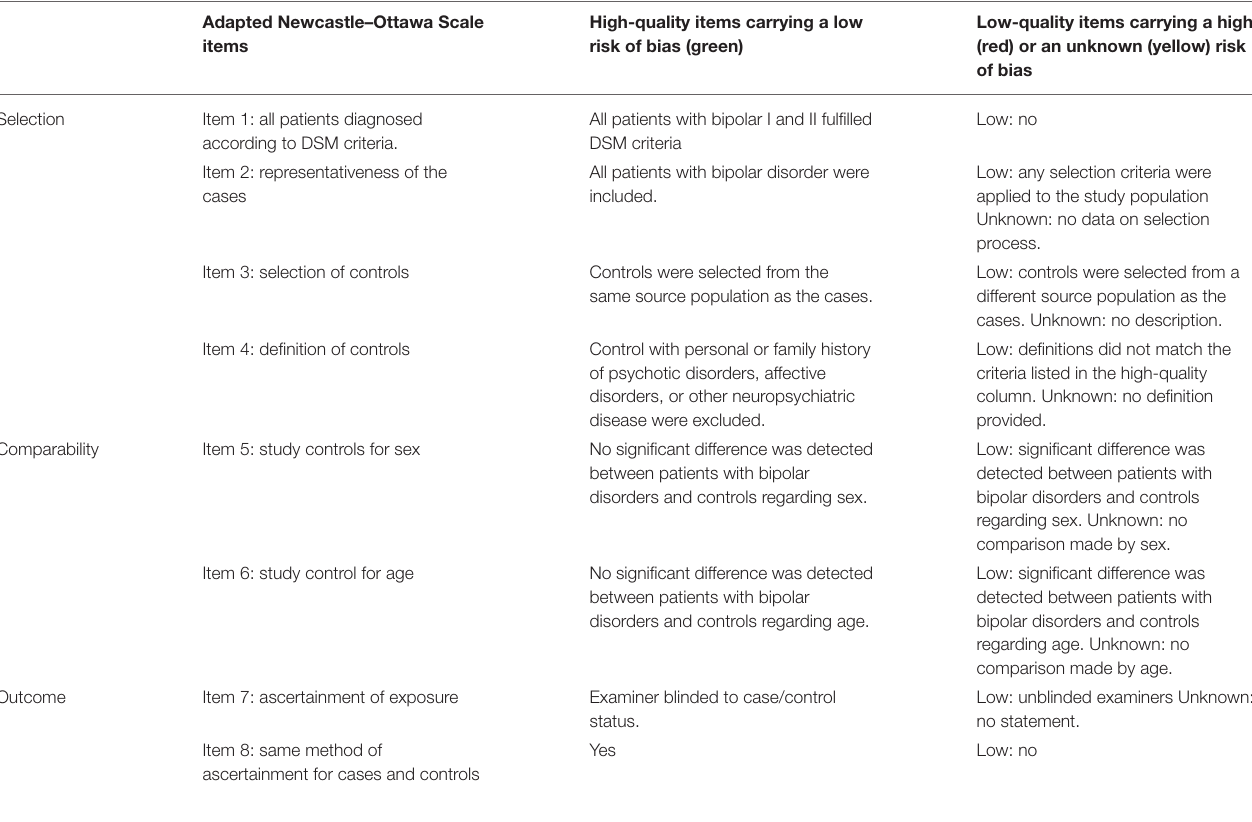
TABLE 1 | The adapted items of the Newcastle–Ottawa Quality Assessment Scale (NOS) to this review. Adapted Newcastle–Ottawa Scale items